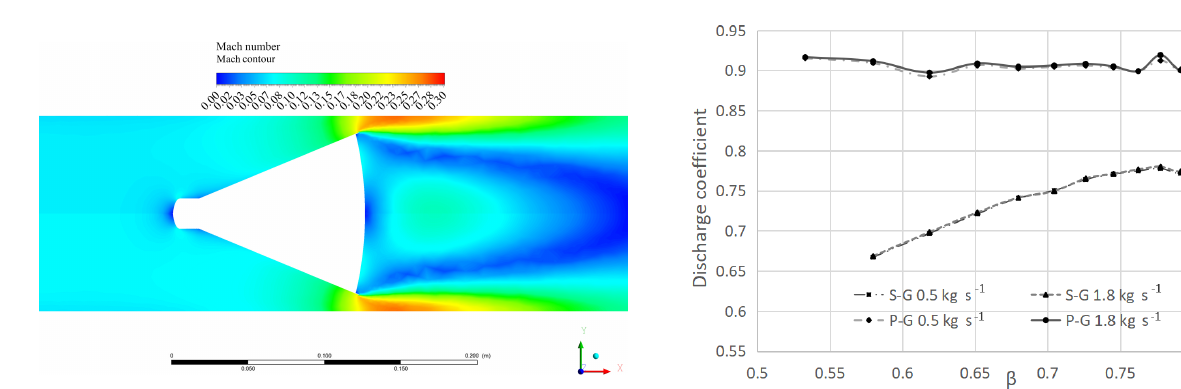
Figure 27. Least squares fit of experimental data, P-G cone.